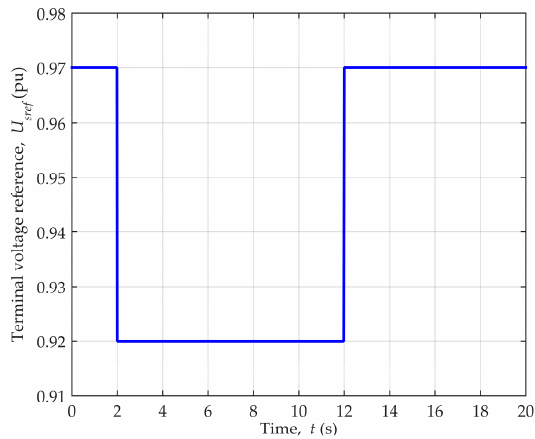
Figure 10. Terminal voltage reference change for generator operating point P = 0.89, Q = 0.11 cap.